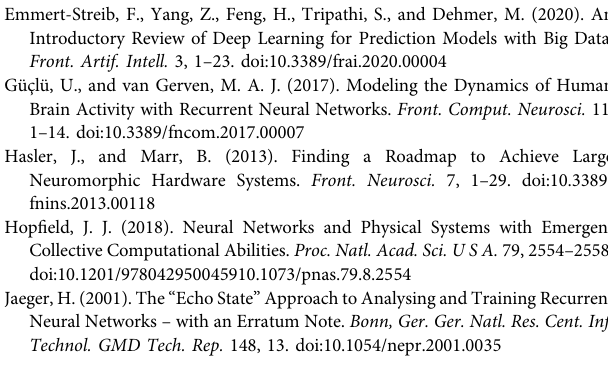
Table S1 . Our dynamic SE-FET-based RC system